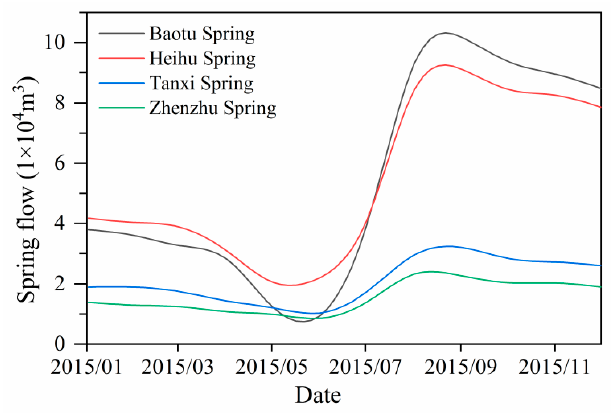
Figure 11. Water level duration curve of the Heihu Spring and Baotu Spring.